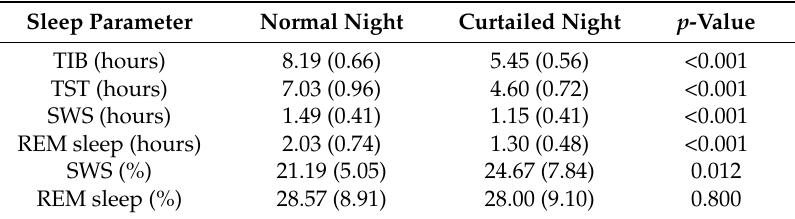
Table 2. Sleep parameters from the Zmachine.